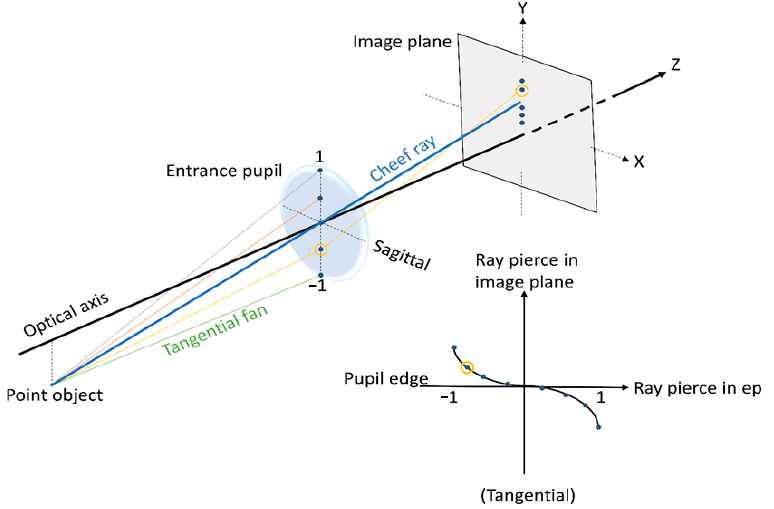
Figure 6. Ray fan plot